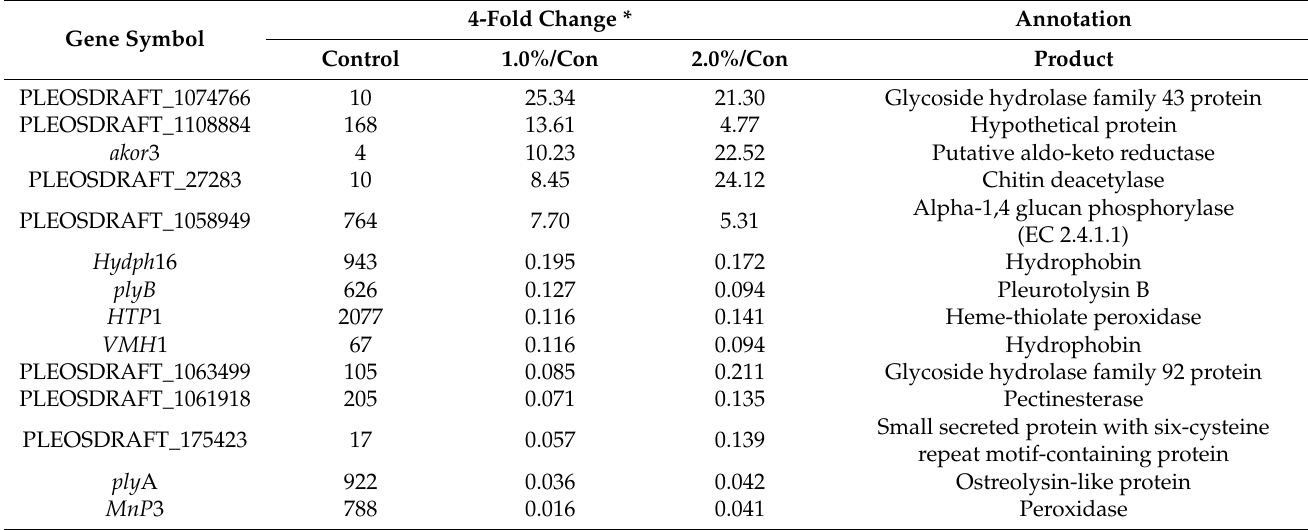
* The values in this table represent the relative expression level compared to the control. A value of 1.0 or more means an increase in gene expression, and a value of 1.0 or less means a decrease in gene expression.